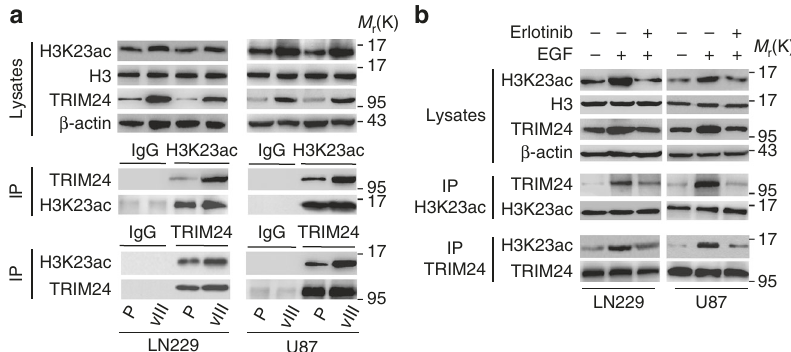
Fig. 2 EGFR promotes the association between H3K23ac and TRIM24. a Immunoprecipitation (IP) and WB analyses of the association between H3K23ac and TRIM24 in LN229 and U87 GBM cells with, or without, EGFRvIII overexpression. b EGFR signaling increases the association of H3K23ac and TRIM24, which is attenuated by the inhibitor erlotinib. EGF (20 ng/ml) stimulated U87 GBM cells with, or without, erlotinib (10 μ m) for 24 h. Data in a and b are representative of three independent experiments. β -actin, IgG and H3 were used as controls